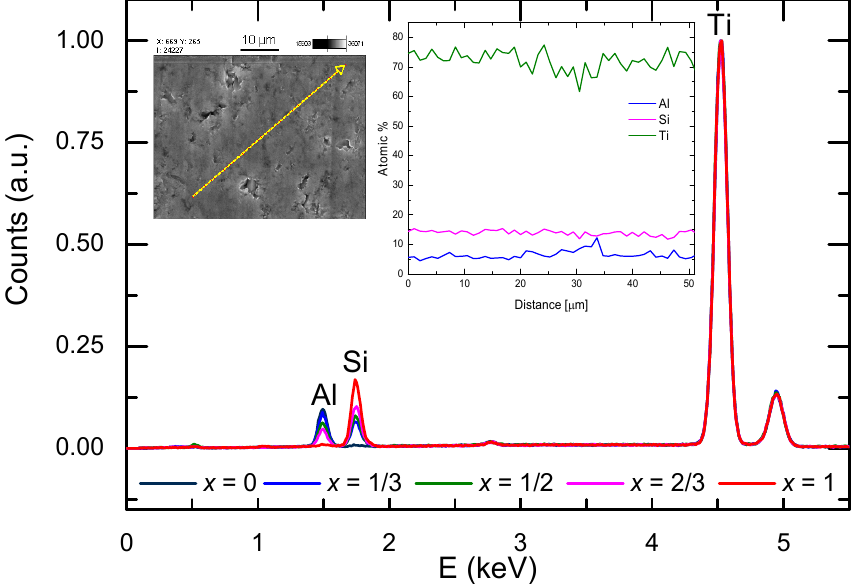
Figure 6. EDX spectra of the Ti 3 (Al 1 − x Si x )C 2 samples. The insets show the SEM image of the surface of Ti 3 (Al 1/3 Si 2/3 )C 2 (the arrow marks the line of the EDS scan) and the plot of concentrations of Ti, Al, and Si along this line.